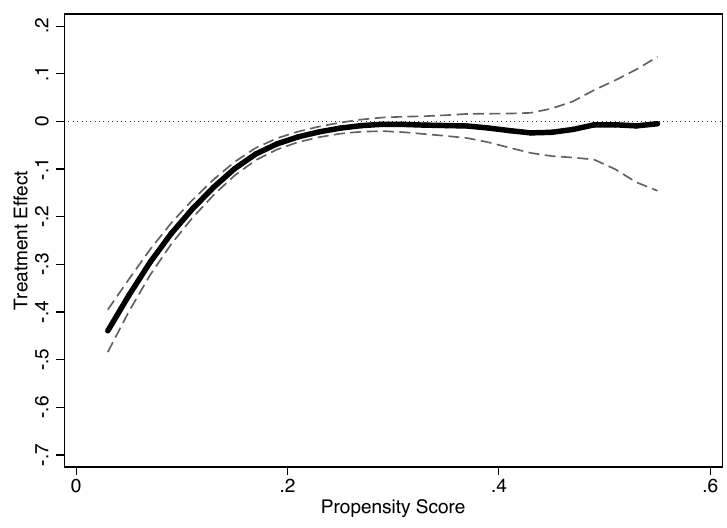
Figure 1: Heterogeneous Community College Effects on Bachelor’s Degree Completion